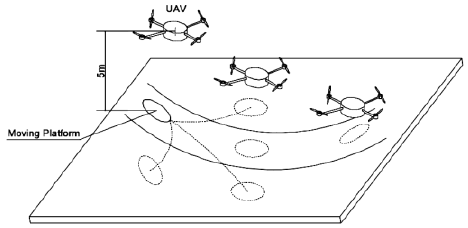
Figure 1. Process of an unmanned aerial vehicle’s (UAV) autonomous tracking and landing, which includes a moving platform and a UAV, in which the UAV’s task is to achieve the tracking of the moving platform and landing on it.